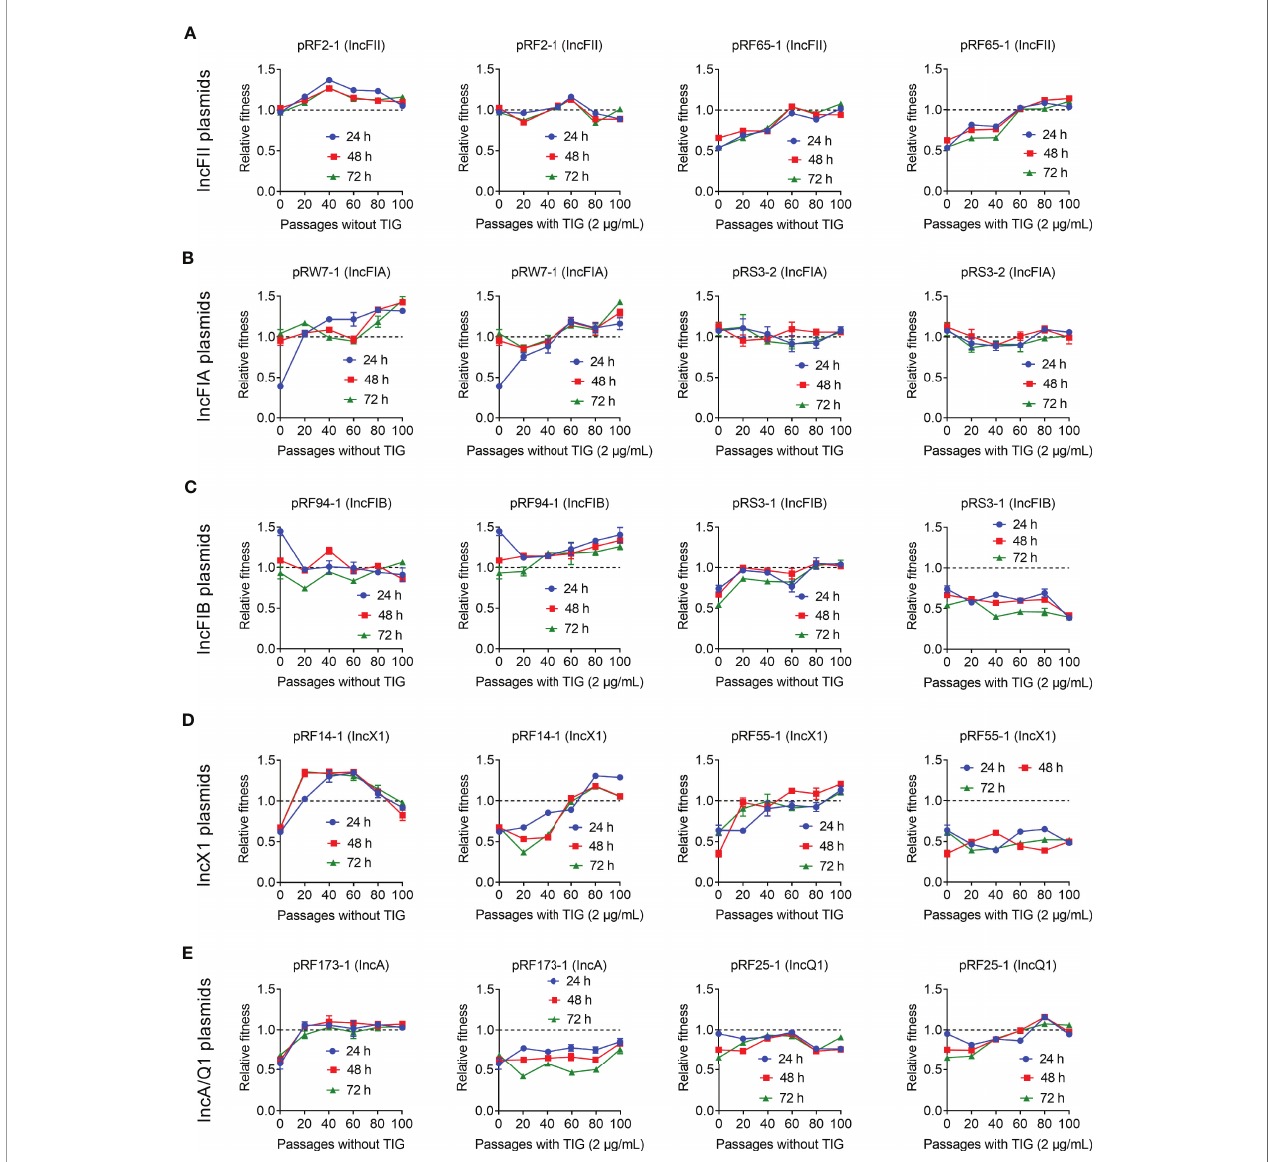
FIGURE 5 | Fitness cost changes of tet (X4)-bearing plasmids in the absence or presence of tigecycline. Transformants carrying tet (X)-positive IncFII (A) , IncFIA (B) , IncFIB (C) , IncX1 (D) , and IncA/Q1 (E) plasmids were competed with a reference strain E. coli TOP10, respectively. All competitions assays were carried out with three biological replicates and last for 100